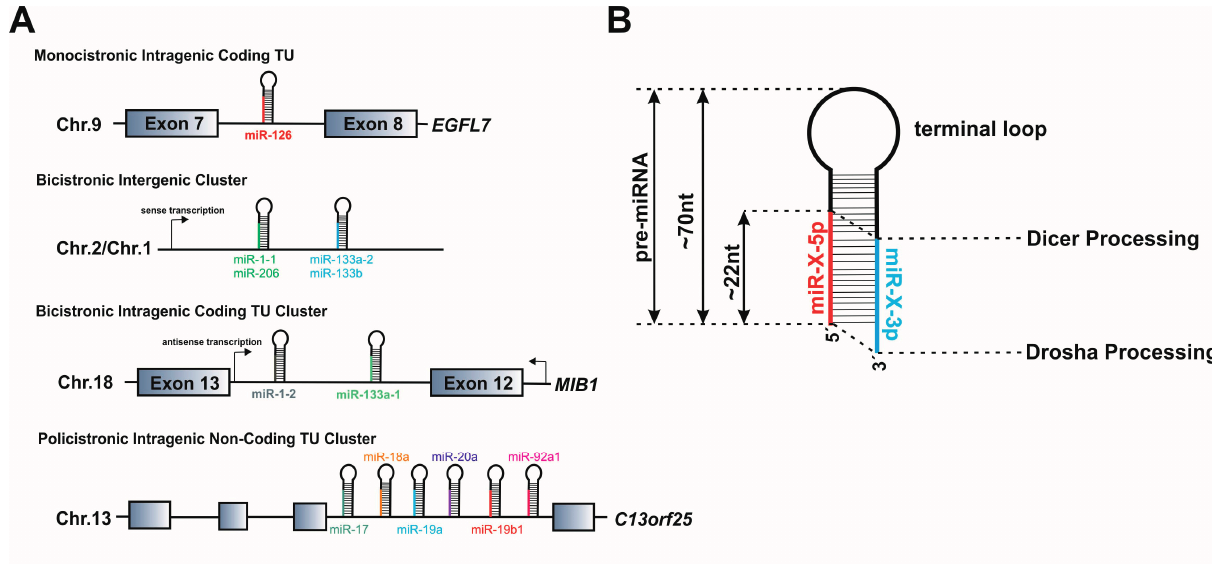
Figure 3. miRNA genomic organization and pre-miRNA hairpin loop features. ( A ) Mammalian miRNA genes are encoded in defined transcription units (TUs) that based on their genomic localization can be classified into three major groups: (i) intronic miRNA genes in protein-coding genes; (ii) intergenic miRNA genes; (iii) intronic miRNA genes in non-coding TUs. miRNA genes can be clustered in a single polycistronic transcript that can be processed in order to generate two or more mature miRNAs. Some miRNA genes are located within TUs with the same transcription orientation as the host gene, whereas others can be transcribed in the anti-sense orientation. ( B ) miRNA precursors fold into a hairpin loop structure that is sequentially processed. Drosha cleaves the pri-miRNA at the base of the stem-loop, generating a pre-miRNA (~70 nt long) precursor that is further processed by Dicer in order to produce a miRNA double-stranded duplex (~22 nt). Both Drosha and Dicer processing generates a characteristic 2 nt 3'overhang. Depending on the relative localization in the hairpin-loop, the mature miRNA can be termed -5p or